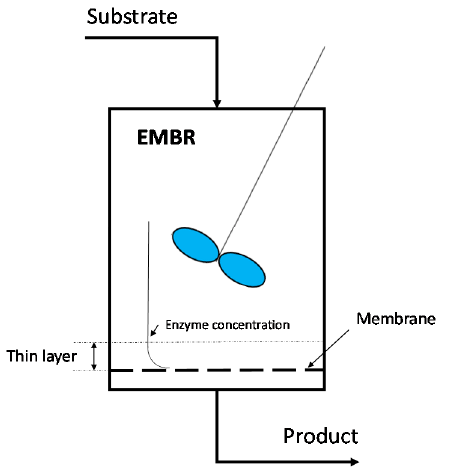
Figure 18. Enzymatic Membrane Bioreactor (EMBR) [78].